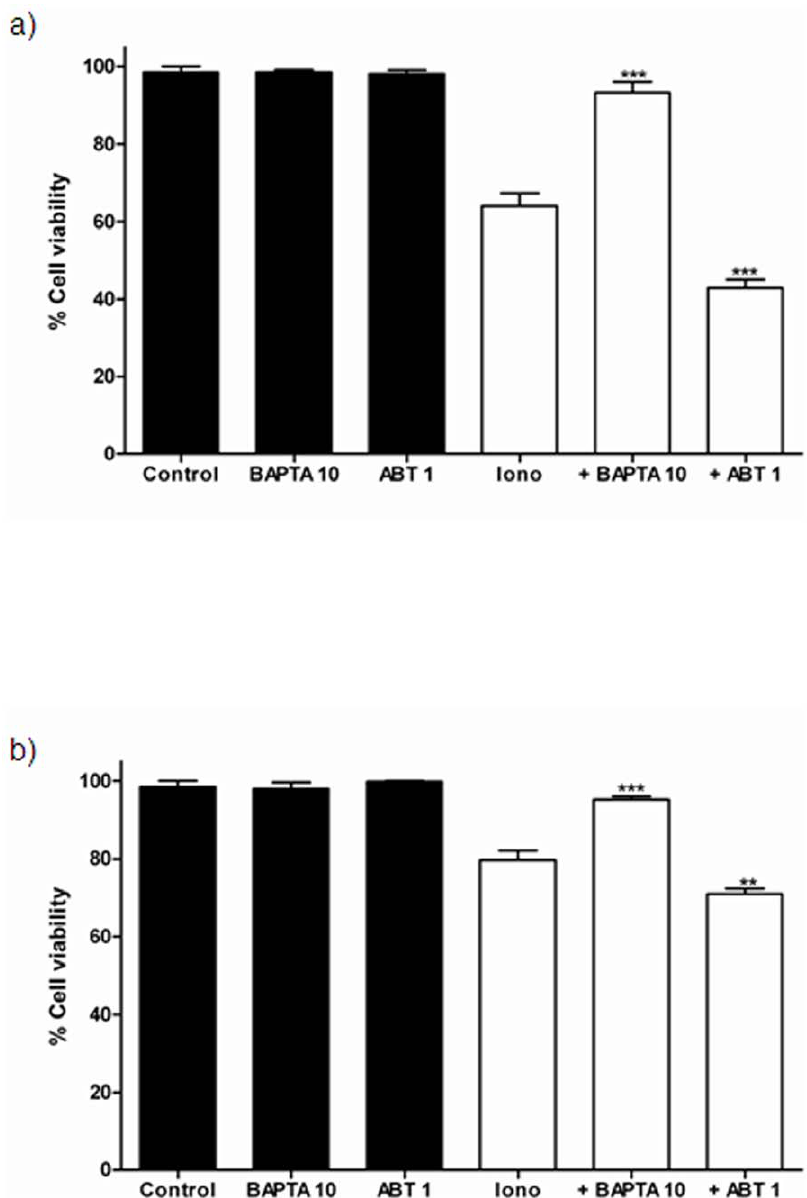
Figure 7. Effect of BAPTA-AM and ABT-737 on ionomycin-induced toxicity in SH-SY5Y cells. The effect of BAPTA-AM and ABT-737 on ionomycin-induced toxicity was studied in both a) SH-SY5Y/Neo and b) SH-SY5Y/Bcl-x L cells treated with either vehicle, BAPTA-AM (10 m M; BAPTA 10) or ABT-737 (1 m M; AB 1) for 30 minutes and then either Ionomycin 2 m M (Iono) was added in the absence or presence of BAPTA-AM 10 m M ( + BAPTA 10) or ABT-737 1 m M ( + ABT 1) for 3 hours and cell viability was determined using the MTT assay. Data represent mean 6 S.E.M. of 12 individual cells from 3 different experiments. **p , 0.01, ***p , 0.001 as compared to Ionomycin-treated cells.